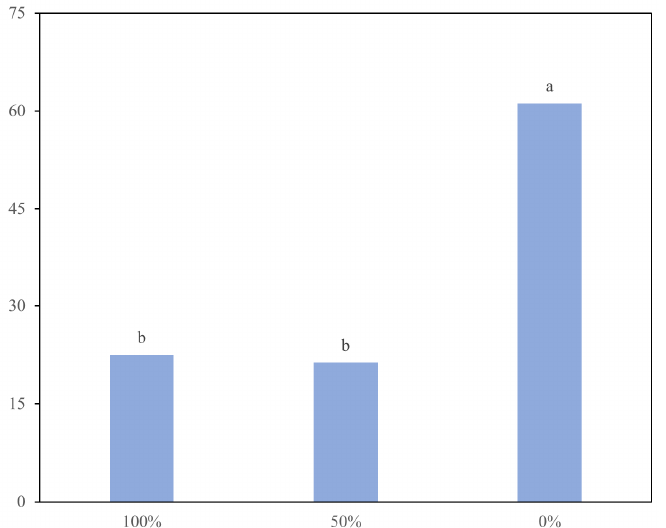
Figure 4. Effects of crop residue removal rates on soil saturation permeability. The bars show the mean values and the lowercase le tt ers indicate signi fi cant di ff erences among treatments ( 𝑝 < 0.05 ). The numbers 0%, 50%, and 100% represent the crop residue removal rates for each treatment.